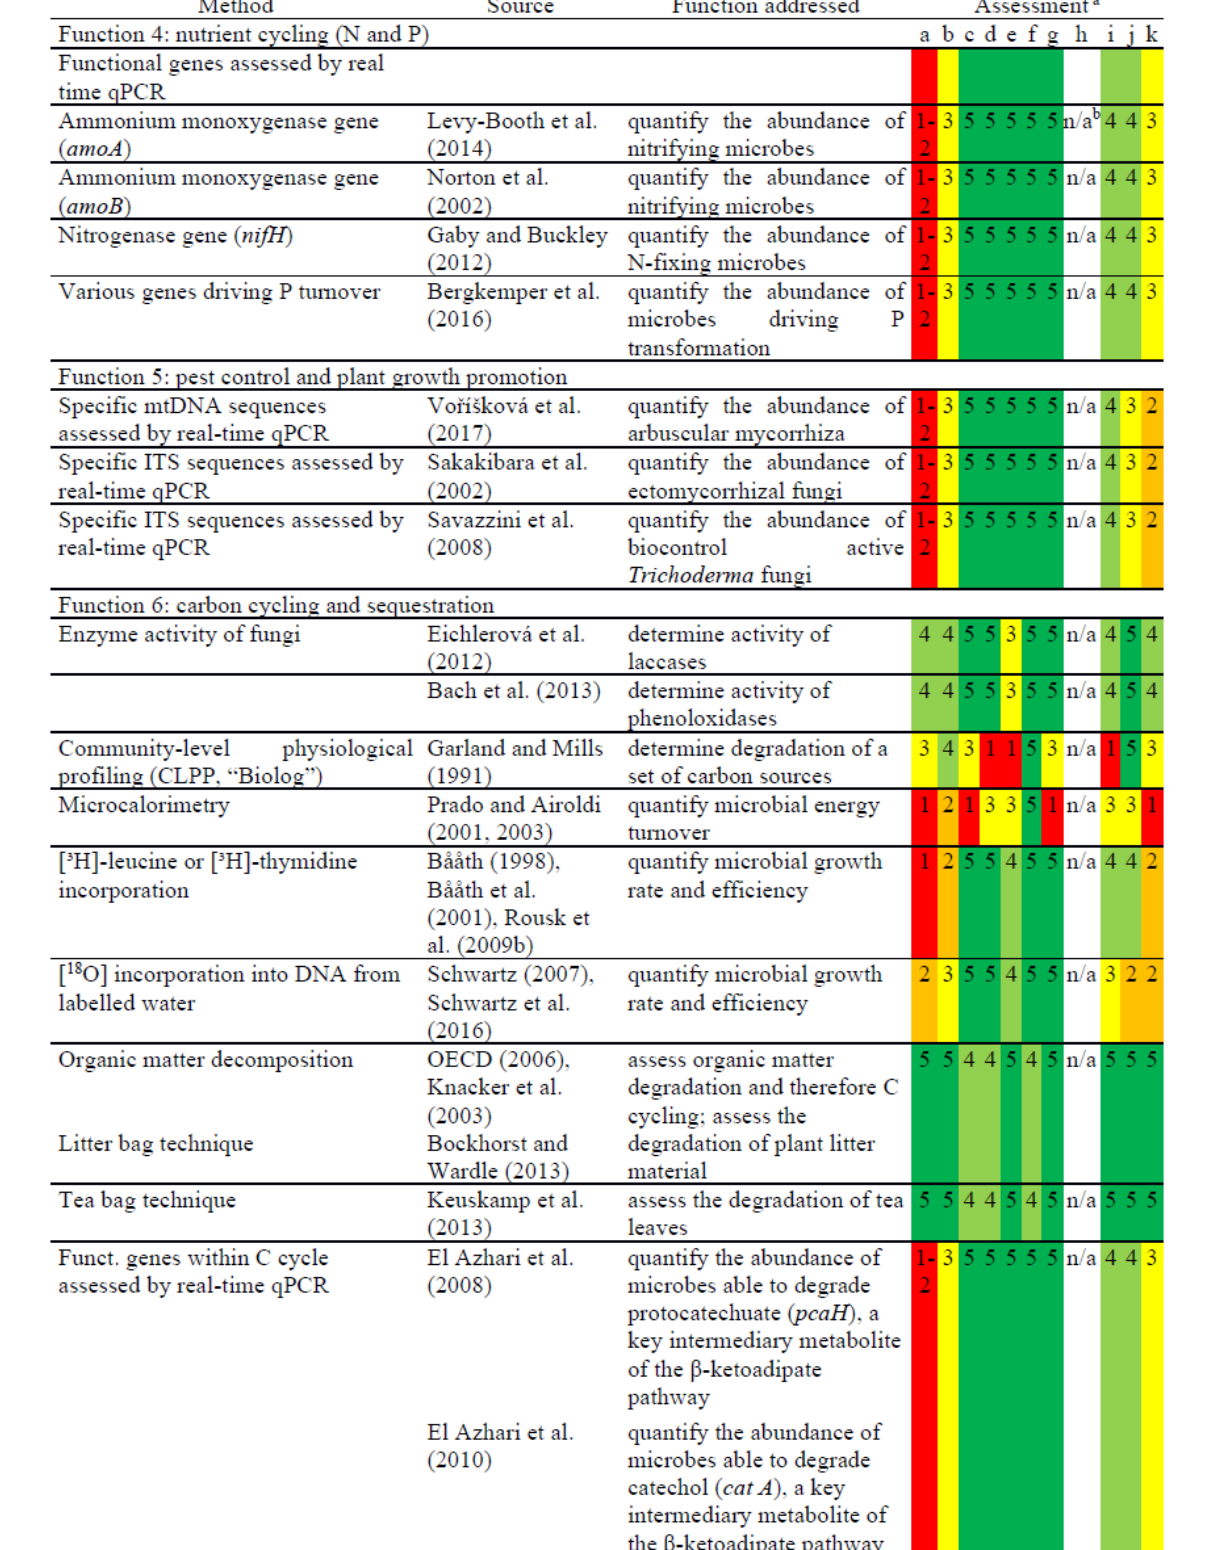
Table 3. Potential new methods for the ISO standardisation process and assessment according to the “logical sieve” selection criteria (de- scribed in Table